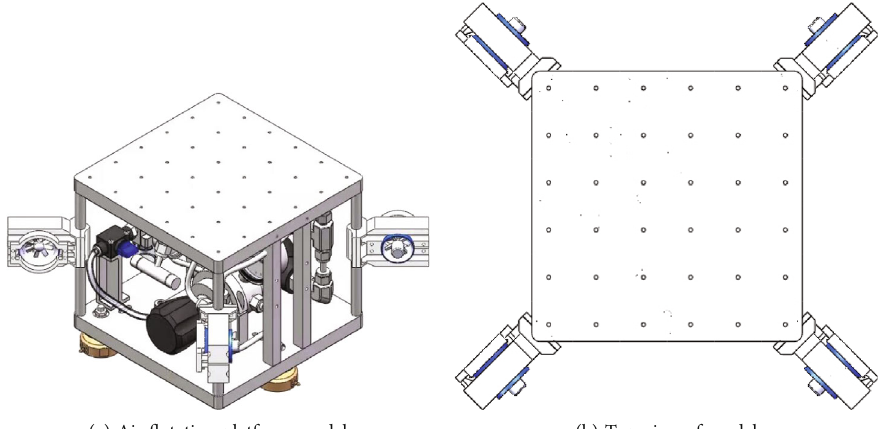
Figure 1: Structural model of air fl otation